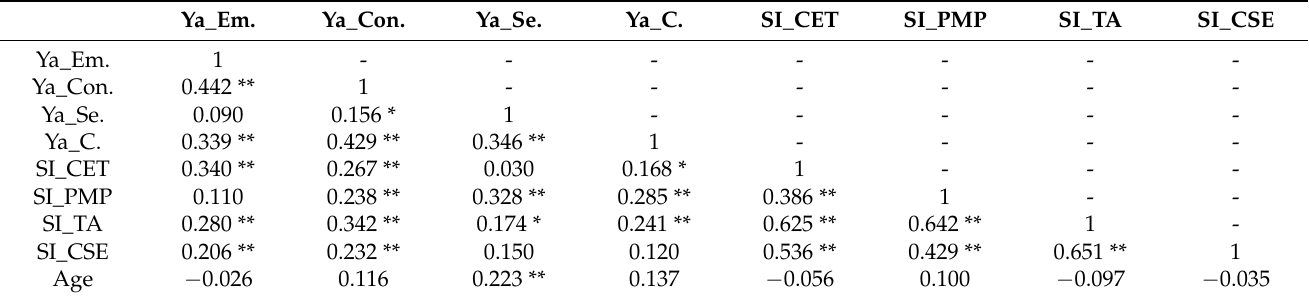
Table 2. Pearson’s R correlations between moral and spiritual intelligence scales and